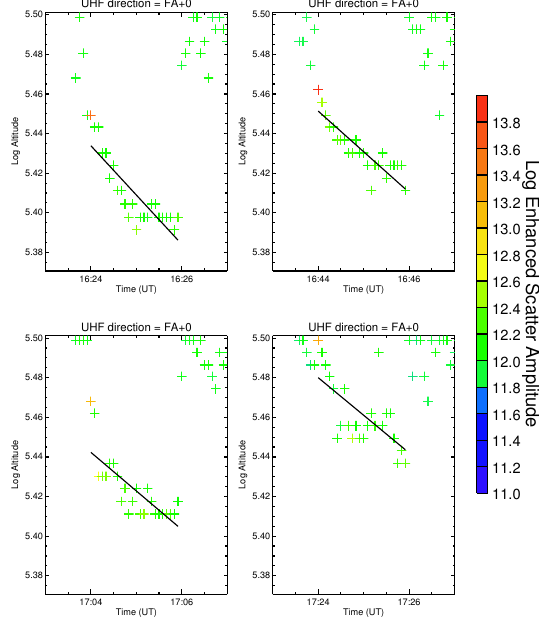
Fig. 9. The logarithm of the altitude plotted against the time, for FA heater and UHF pointing. Four cases are shown. The fit was per- formed in order to attempt to characterize the electron concentration increases using an exponential function. There is good agreement between the fitted lines and the